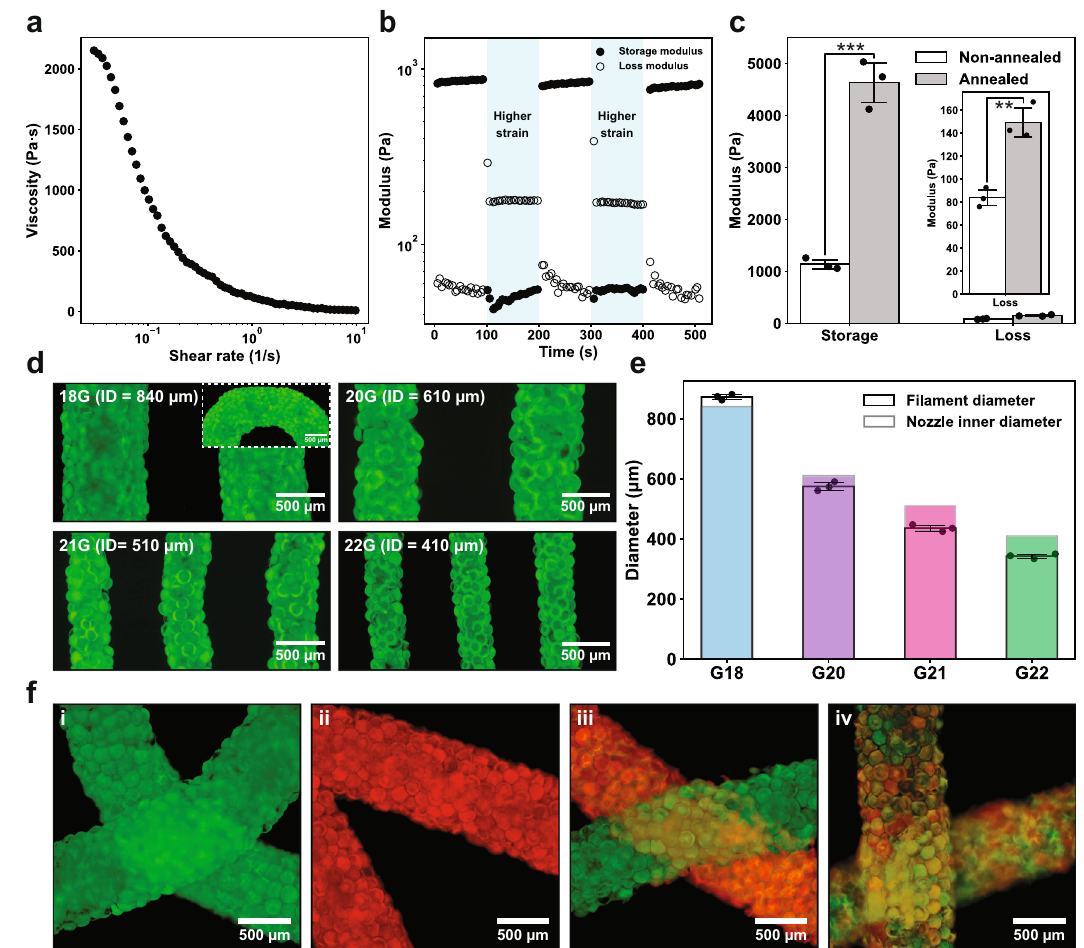
fi lament. e Analysis of the fi lament diameters. Colored bars represent the inner diametersoftheprintingnozzlesandtheblankonesarethemeasureddiametersof printed fi laments, n =3 independently printed fi laments in one experiment. f Fluorescentimagesofscaffolds,i.e.,(i)greenand(ii)redhomogeneousscaffolds, (iii) a macroscopically heterogenous scaffold, and (iv) a microscopically hetero- genousscaffold. d , f Fluorescentmicrogelsaregeneratedfromamixtureofgelatin with fl uorophore-labeled gelMA. Data are presented as mean values ± standard deviation and source data are provided as a Source Data fi